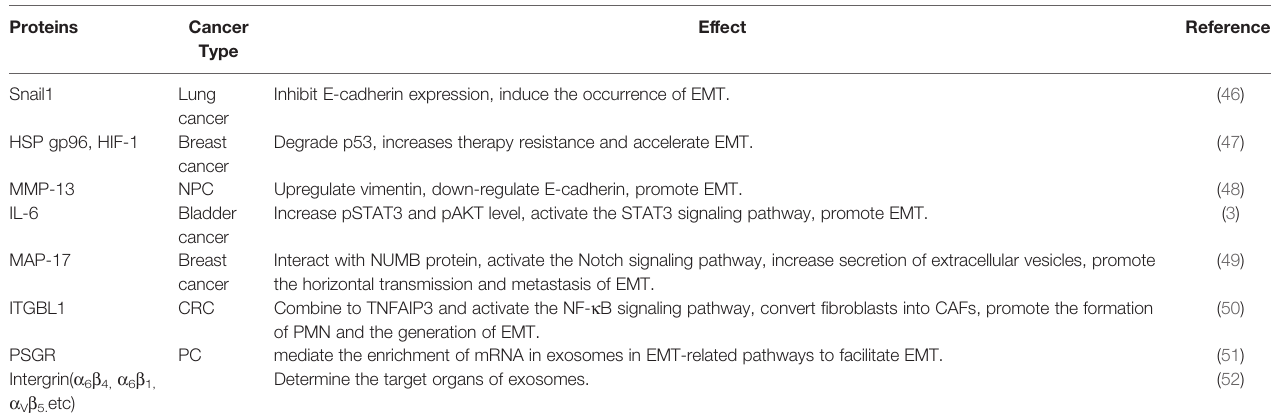
TABLE 1 | The effects of proteins carried by exosomes on EMT. Proteins Cancer